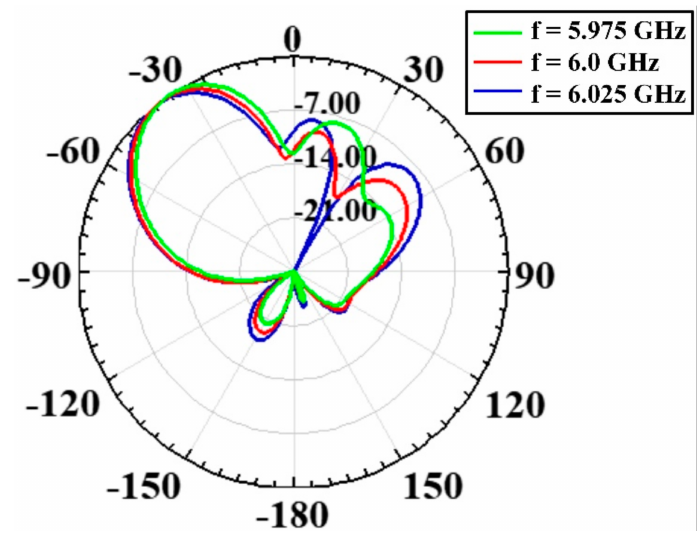
Figure 7. Radiation beam plots (H-plane) at three different frequencies